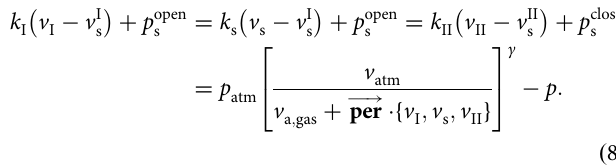
Equation (8) describes an adiabatic process, and for an isothermal process the fi rst RHS term is replaced with ð m ; v ; v ð v þ per (cid:2)(cid:2)! (cid:3)f v gÞ . a ; gas I s II Solving Eq. (8) for the equilibrium values v I , v s and v II , and substituting these into the energy equation (7) allows to calculate the energy of the suspension per given permutation per ; n ; n f n g and external pressure p . Each permutation is only I s II valid in a speci fi c range of external pressures, as de fi ned in Eq. (4). In Fig. 2 we present all of the available energy equilibria states, for multistable capsules composed of 18 bi-stable elements, with 190 possible permutations. Both isothermal (orange lines) and adiabatic (blue lines) processes are presented. The lines are determined by changing the external pressure, for different permutations of the phases of the bi-stable elements. The results show that the multi-stability extends the possible state of an